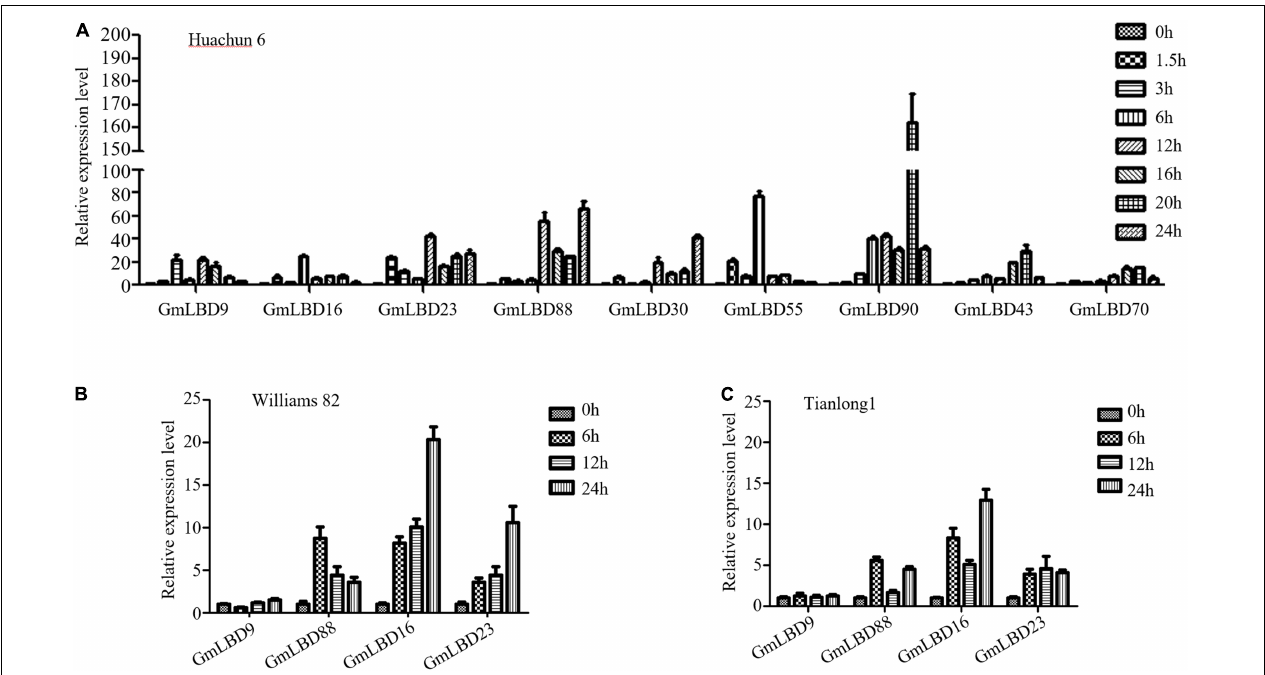
FIGURE 4 | Expression profiles of GmLBD genes in Huanchun 6, Williams 82, and Tianlong 1 cultivars upon P. sojae infection. (A) Soybean hairy roots were collected at 0, 1.5, 3, 6, 12, 16, 20, and 24 h after P. sojae strain P6497 infection. Total RNA was extracted and expression profiles of 9 GmLBD genes at various time points during infection were determined by qRT-PCR. The Soybean GmCYP2 gene was used as an internal control. Error bars indicate three biological replicates. Soybean hairy roots of Williams 82 (B) and Tianlong 1 (C) were collected at 0, 6, 12, and 24 h after P. sojae strain P6497 infection. Total RNA was extracted and expression profiles of 4 GmLBD genes at various time points during infection were determined by qRT-PCR. The Soybean GmCYP2 gene was used as an internal control. Error bars indicate three biological